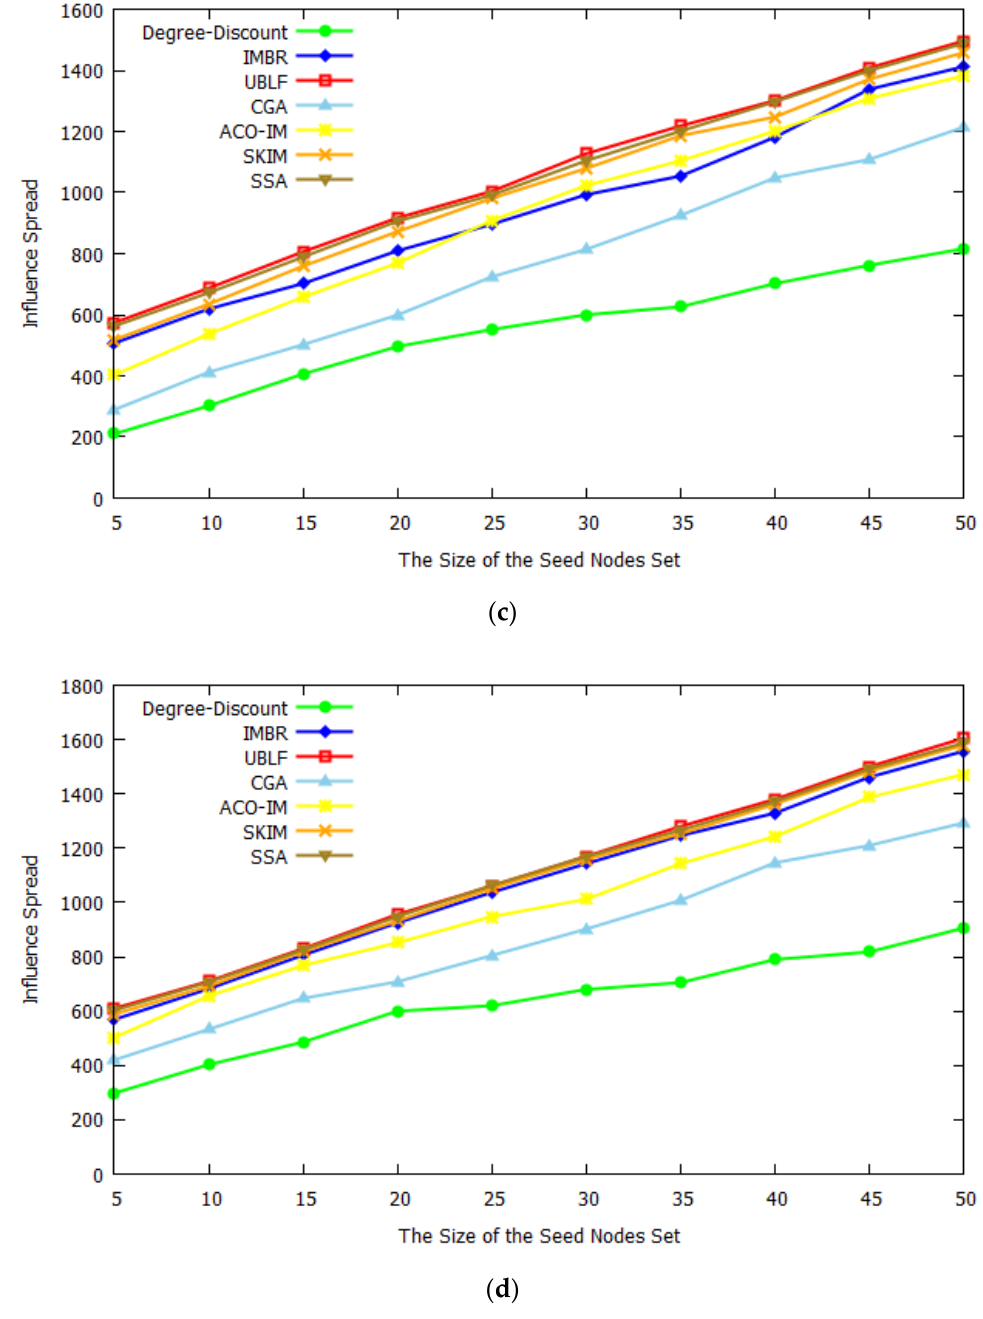
Figure 3. Comparison of the influence spread of IMBR with other algorithms on different datasets. ( a ) Comparison of the influence spread of IMBR with six rival algorithms on the Facebook dataset. ( b ) Comparison of the influence spread of IMBR with six rival algorithms on the ca-HepTH dataset. ( c ) Comparison of the influence spread of IMBR with six rival algorithms on the Epinions dataset. ( d ) Comparison of the influence spread of IMBR with six rival algorithms on the Twitter dataset.